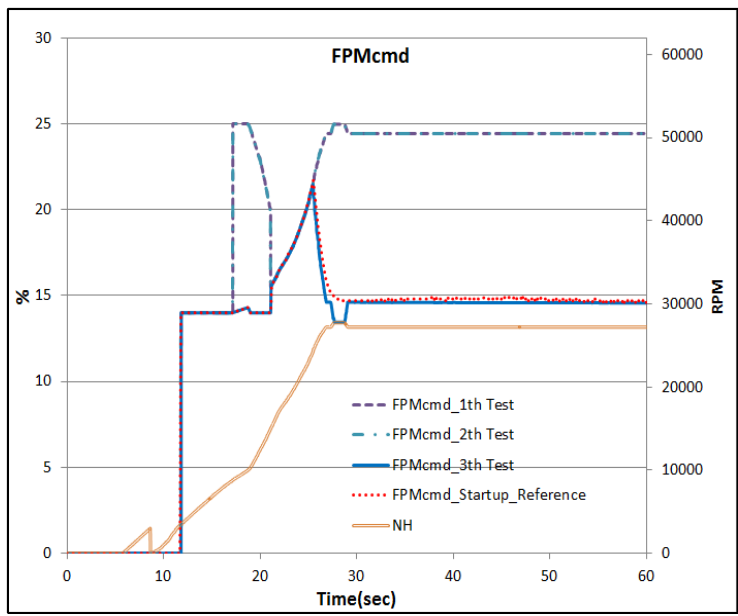
Figure 13. Result of EECU control logic verification test (FPMcmd).